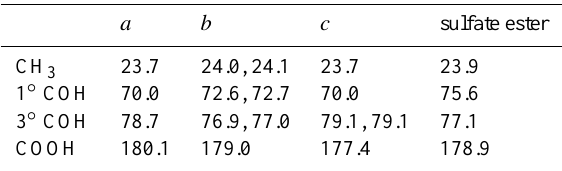
Fig. 5. 13 C spectrum of 2-MG, 2-MG diester and nitrate ester (So- lution 14). See Fig. 3 for key to labels. Table 4. 13 C NMR assignments for 2-MG and derivatives (in ppm, relative to DSS) for Solution 12. See Fig. 3 for key to labels of